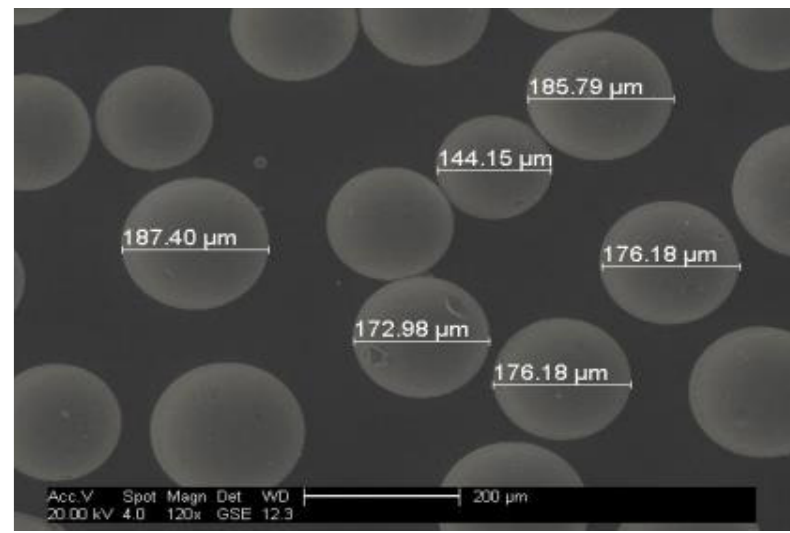
Figure 8. Microscopic image of the glass beads [27].